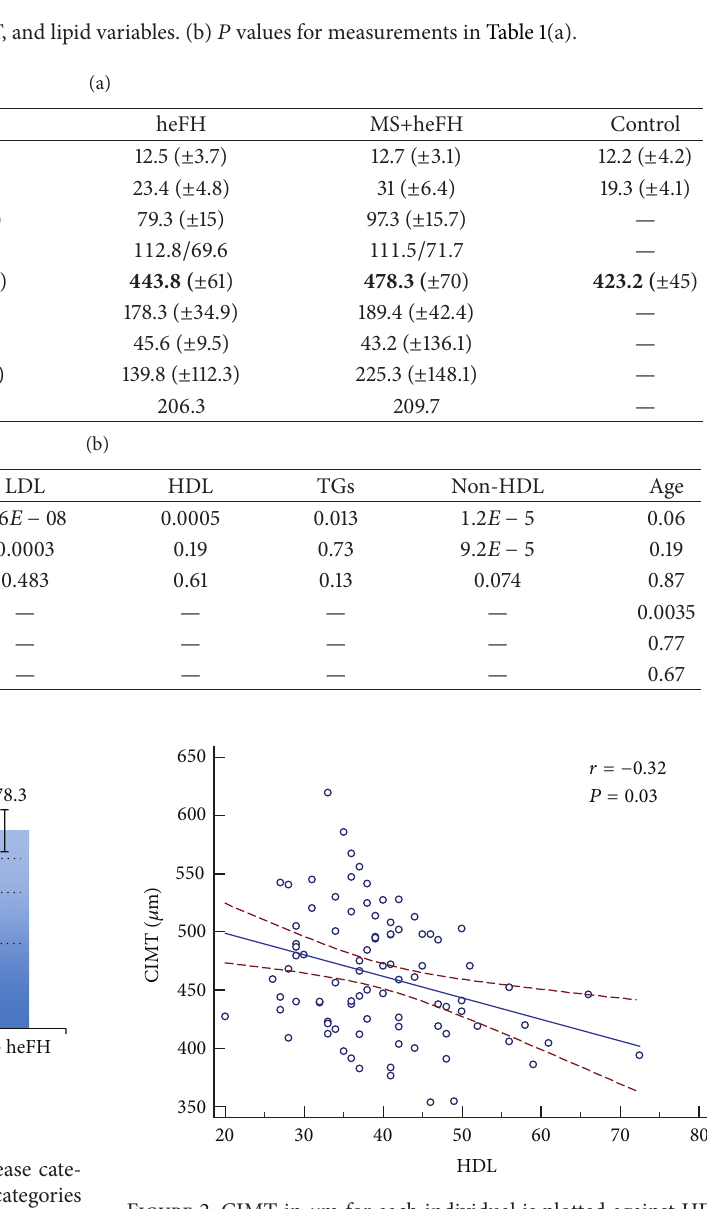
𝜇 m for each individual is plotted against HDL (mg/dL). The regression line is shown as solid line and the 95% confidence interval of the regression is plotted as the dashed